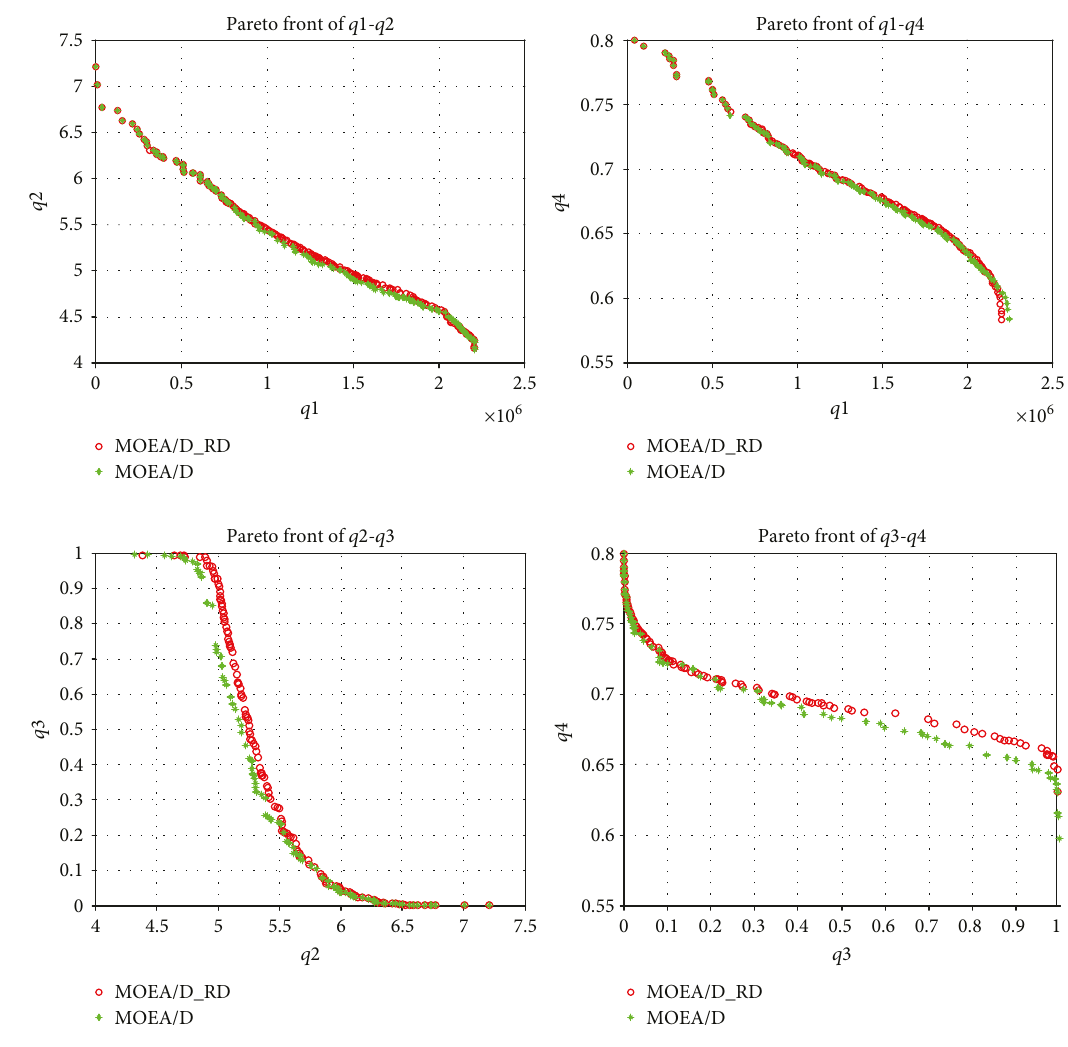
Figure 8: Comparison of PF between MOEA/D_RD (red circle) and MOEA/D (green ∗ ) for 2-objective